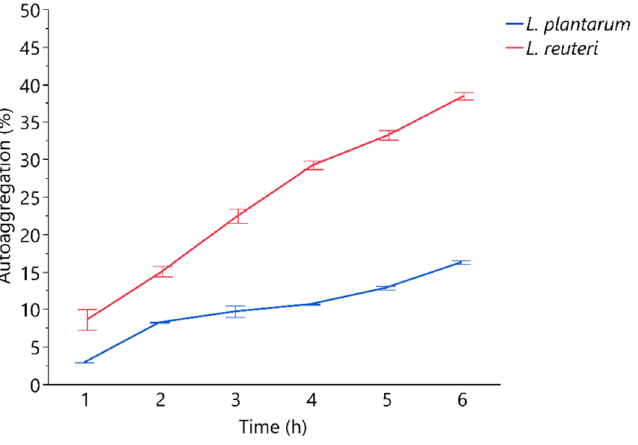
Figure 1. Percentages of autoaggregation measured at hourly bases. Data are presented as means ± standard deviations.